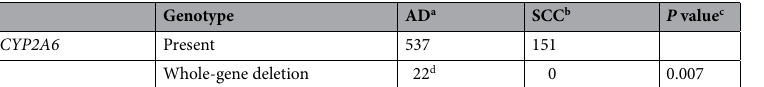
Table 5. Genetic variants of CYP2A6 show significantly different frequencies between adenocarcinoma and squamous cell carcinoma in patients with lung cancer. a AD adenocarcinoma, b SCC squamous cell carcinoma, c P value by Fisher’s exact test. d Smoking status of patients with CYP2A6 whole-gene deletion; Never = 14, Light = 3, Heavy = 5. d Sex of patients with CYP2A6 whole-gene deletion; Female = 16, Male =